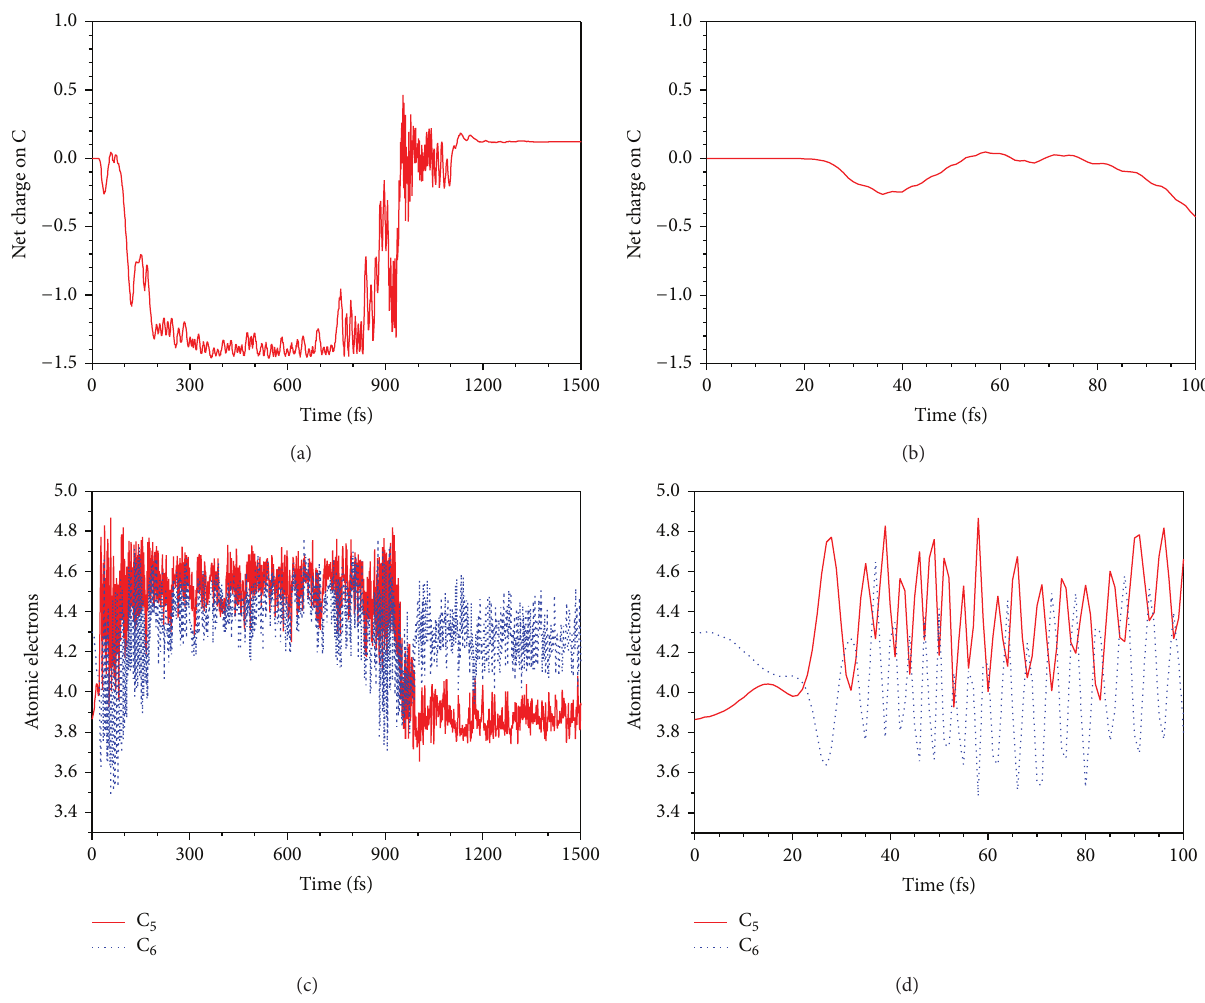
Figure 3: Variations with time of the net charge on C and the valence electron numbers of C 5 and C 6